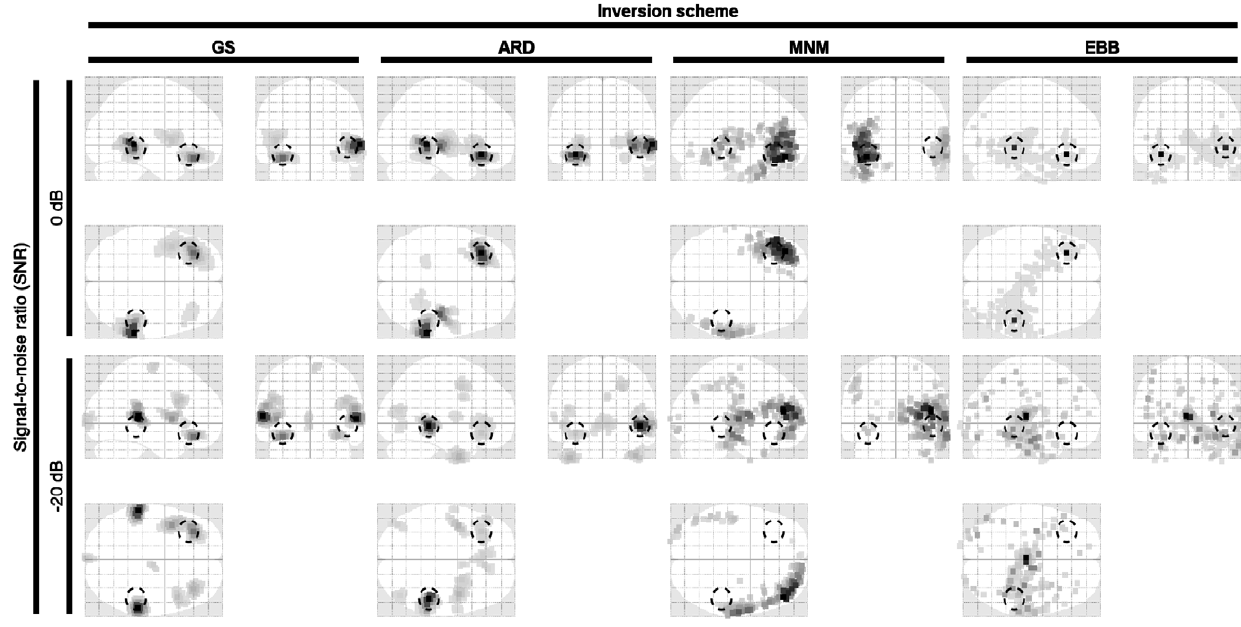
Figure 6. Example of localization performances at 0 and 20 dB. Two asymmetrical, weakly correlated sources are simulated in the forward problem. Symmetrical correlated priors are considered for ARD and GS. The actual simulated dipoles are centered at the dashed circles. EBB performs almost flawlessly at high SNR at high SNR. GS and ARD still show some local maxima in the actual source location at extremely low SNR.